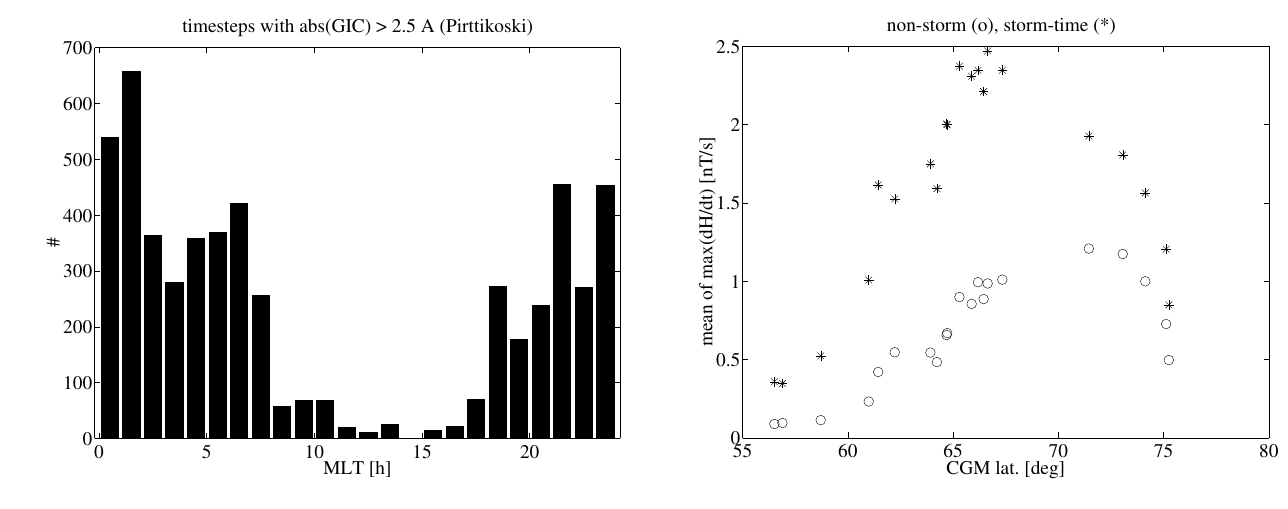
of max( j d H /dt j ) during substorms as a function of the CGM latitude. Fig. 2. Average Circles: non-storm substorms, asterisks: storm-time substorms.